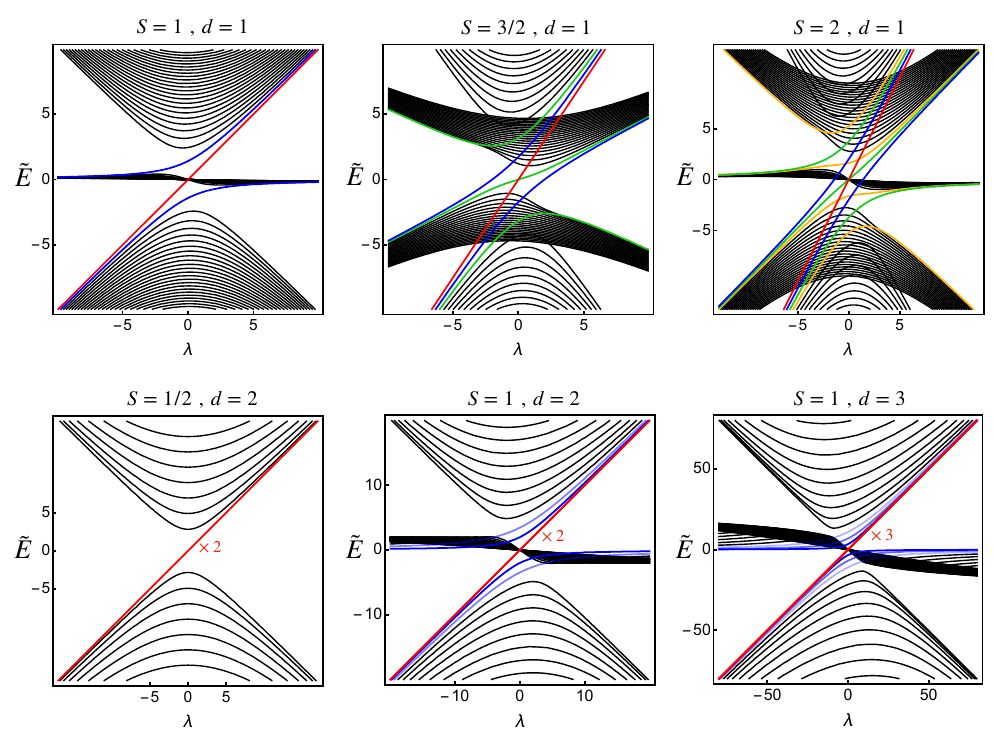
Figure 9: A few examples of full eigenvalue spectra ˜ E of ˆ and d = 1. The black branches are obtained with the anzatz 0 as in figure 8 and the colored spectral flows are obtained by applying the successive anzatz Ap (128) : (red) p = 2 S , (blue) p = 2 S − 1, (green) p = 2 S − 2 and (yellow) p = 2 S −